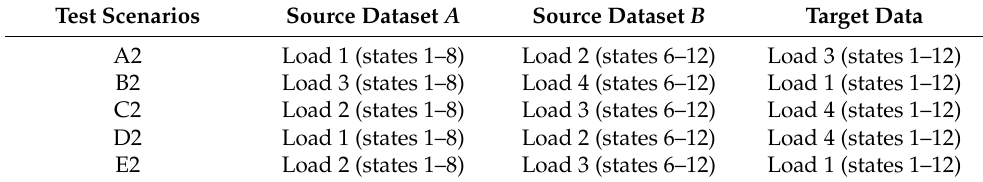
Table 12. Five different test scenarios.